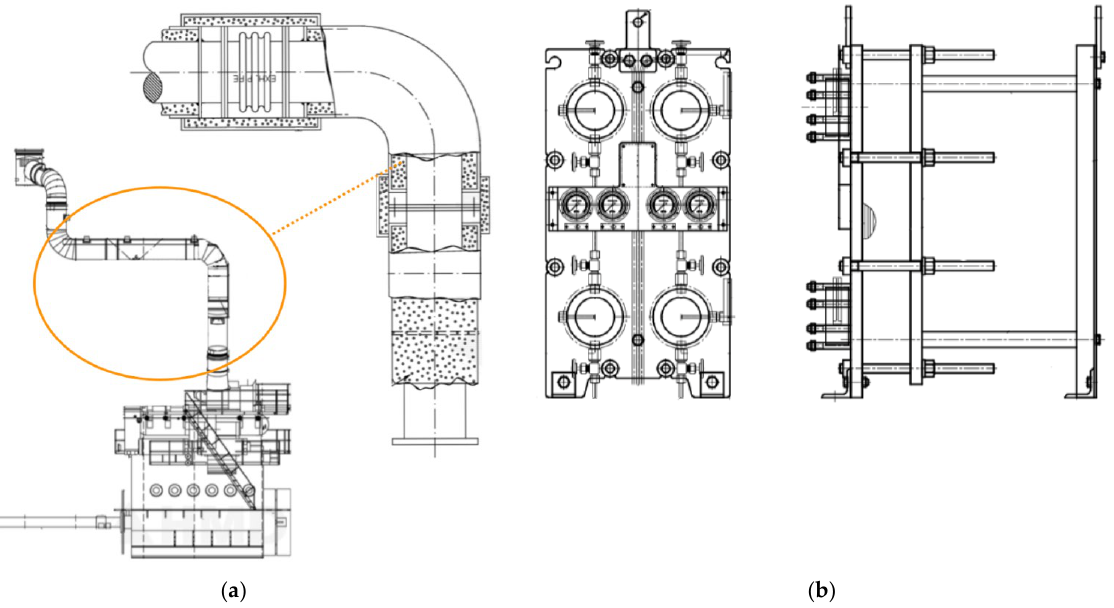
Figure 2. ( a ) Surface area for the TEG system designed on the ME exhaust outlet line; ( b ) Surface for the TEG system designed on the ME JCW heat exchanger.